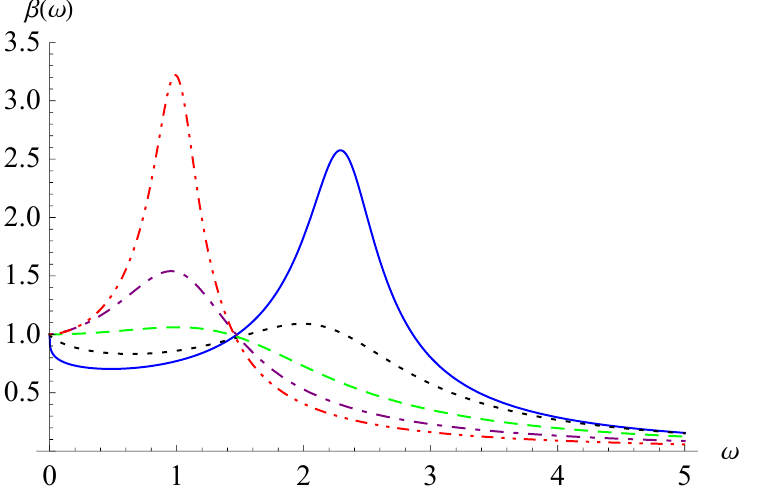
Figure 1. Curves of amplitude ratio β ( ω ) = Xk / F for m = 1, b = 2, k = 3 and α = 0.3 (solid line), α = 0.65 (dot line), α = 1 (dash line), α = 1.35 (dot–dash line), α = 1.7 (dot–dot–dash line).